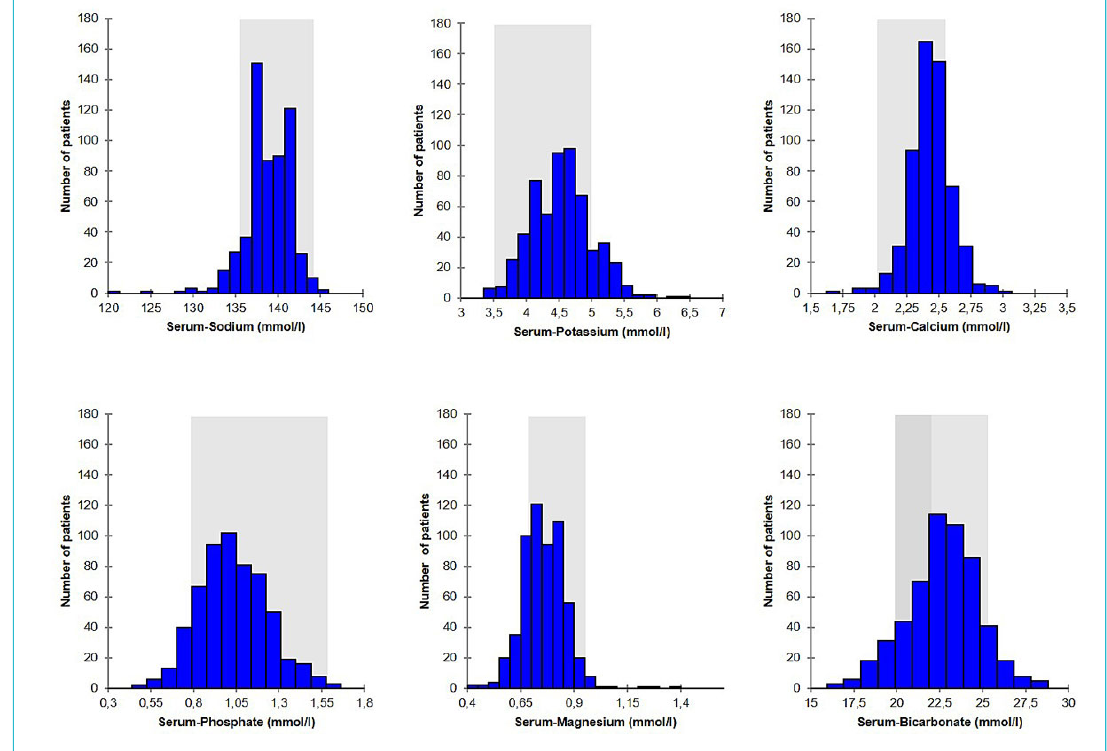
Figure 1: Distribution of serum electrolyte levels. The grey area in each figure represents the normal range of serum electrolytes, except in fig- ure “serum-bicarbonate” the lighter grey marks the range of 22–26 mmol/l, the darker grey the area between 20–26 mmol/l, as used in the